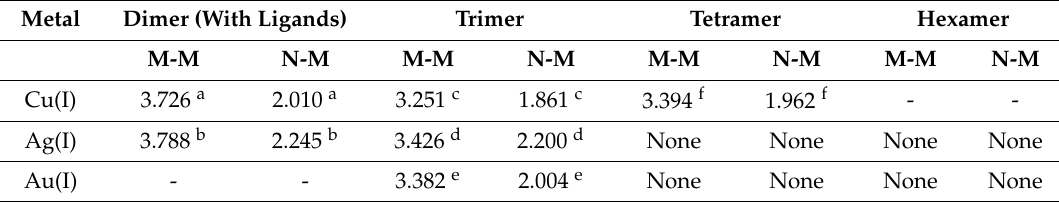
Table 4. Experimental metal ··· metal and metal ··· N atom (Å) (averaged and parent